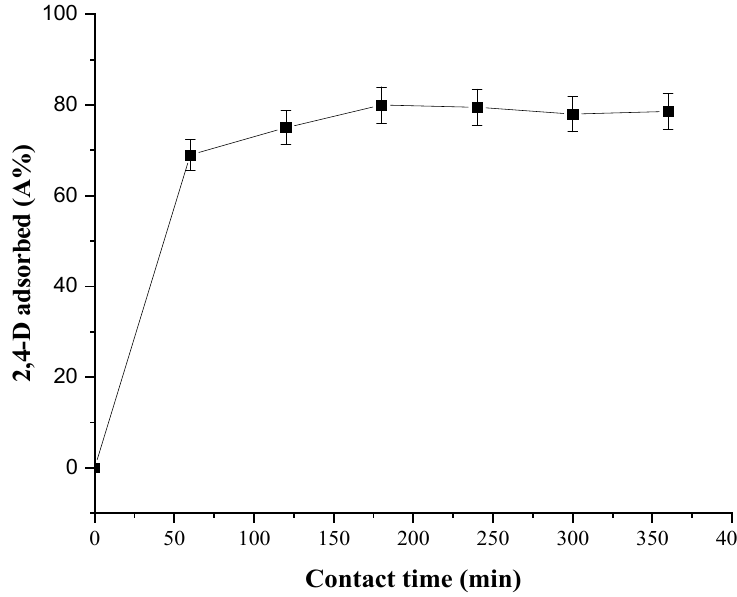
Figure 8. Effect of contact time on 2,4-D percentage removal. The error bars show the standard deviation for three different sample runs.